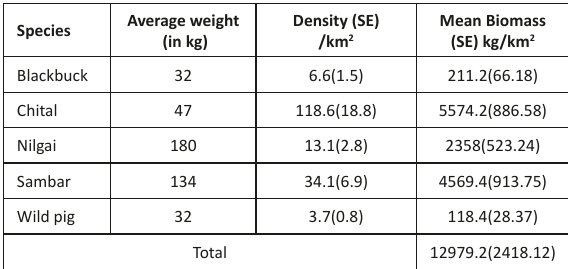
Table 3. Biomass estimates for ungulates in VVNP, Bhopal.